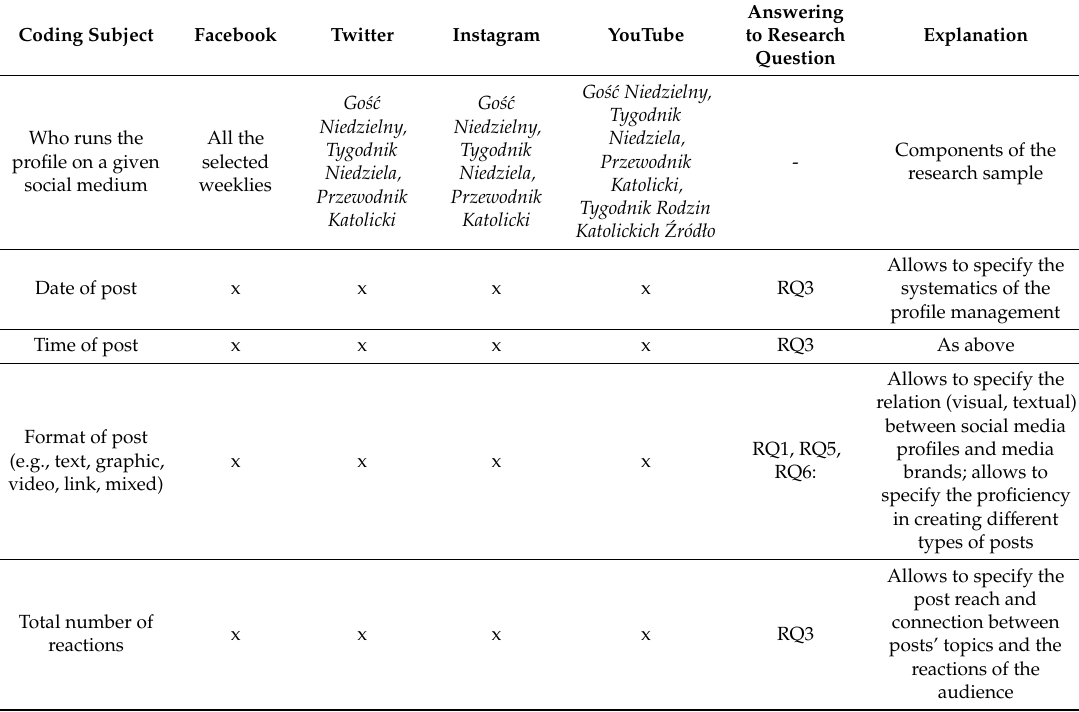
Table 1. Content coding schedule—Stage